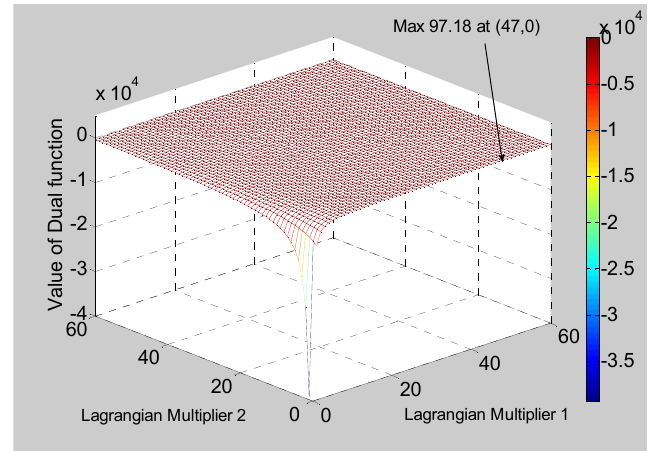
Figure 5. Dual function for a Target Scenario 1.